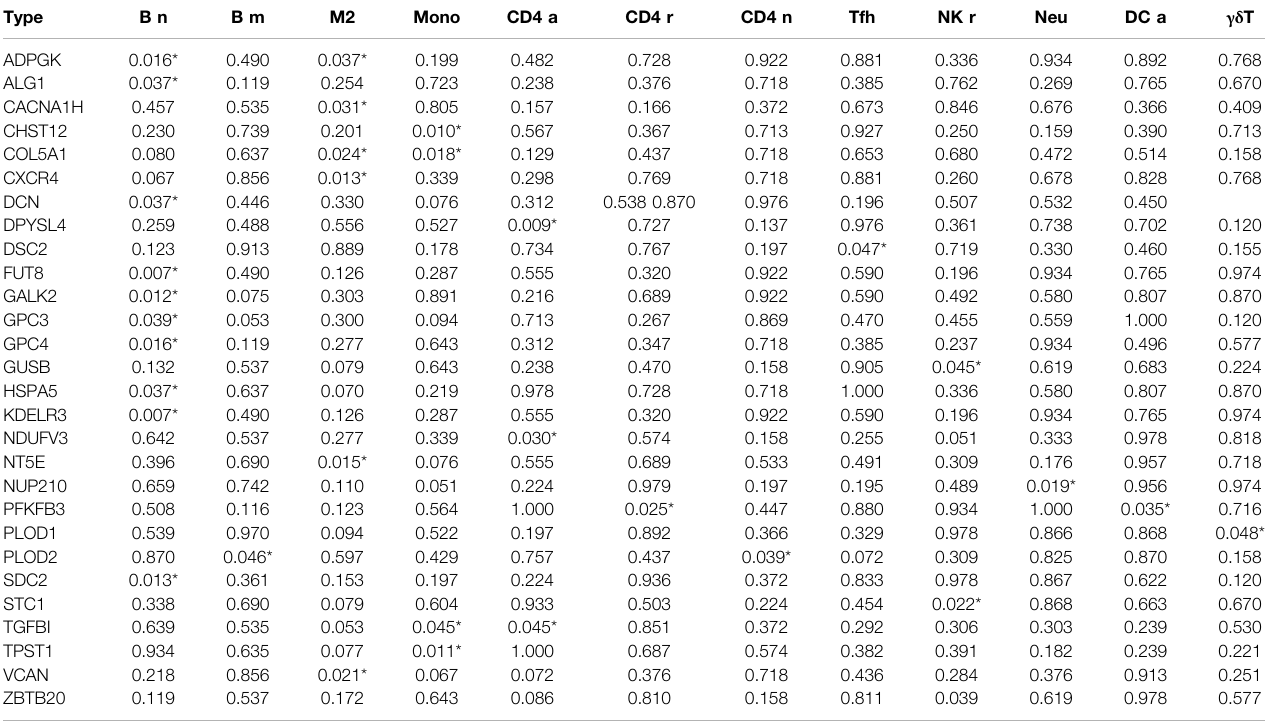
TABLE 2 | Impacts of glycolytic genes on immune cells in TME. Type